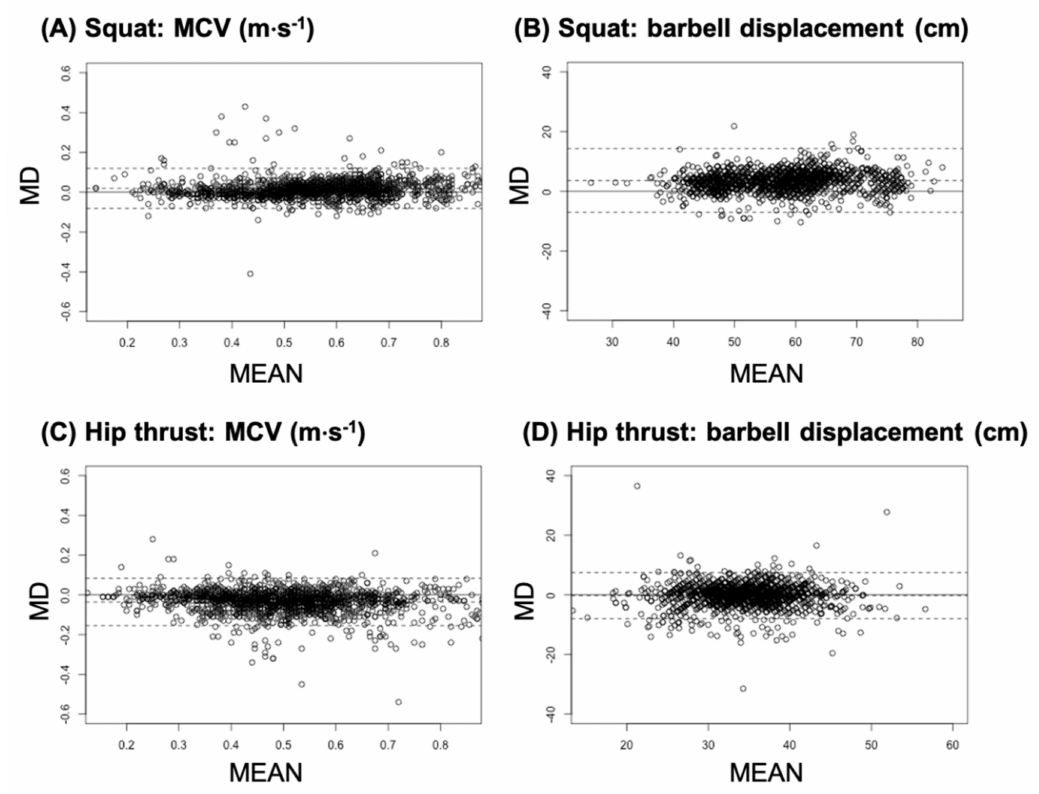
Figure 2. Bland–Altman plots (MD: mean difference between both devices; MEAN: average of both devices) for the validity of the Speed4Lift ® (S4L) vs. the VmaxPro ® (VMP) sensors for the mean concentric velocity (MCV; A , C ) and barbell displacement ( B , D ). Squat (SQ; A , B ) and hip thrust exercises (HT; C , D ) are displayed separately. Table 2. Within- and between-day reliability of the mean concentric velocity (MCV) and barbell displacement for Speed4Lift ® (S4L) and VmaxPro ® (VMP) sensors for squat (SQ) und hip thrust (HT) exercises. Device